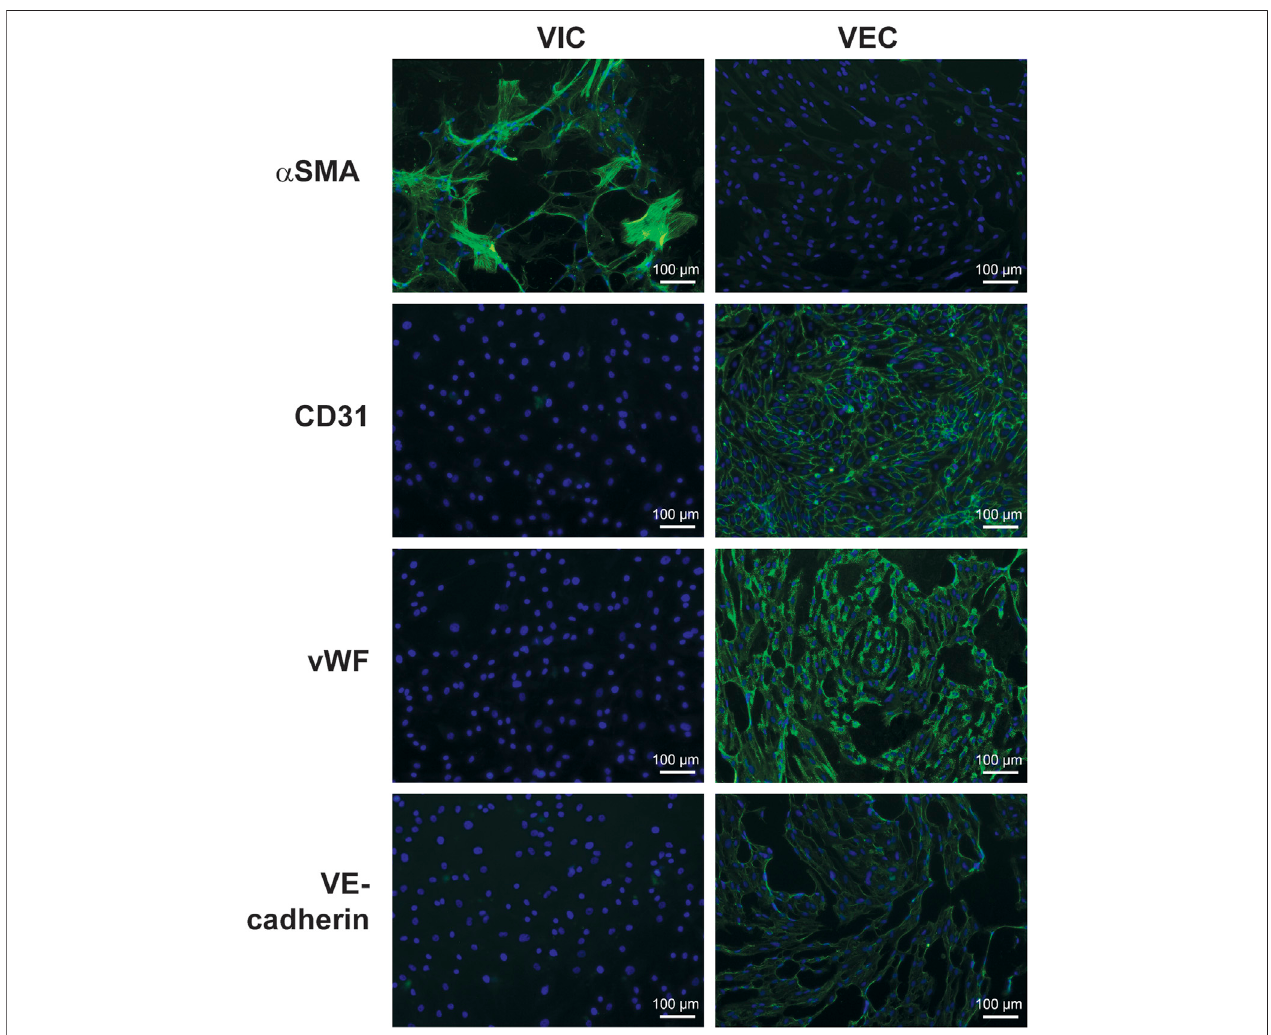
FIGURE 3 | Immuno fl uorescence staining for fi broblastic and endothelial markers in valve interstitial (VIC) and endothelial cells (VEC). Cells were isolated from humanaorticvalveswithcalci fi cation(n=3)andseparatedbymagnetic-activatedcellsorting.Thepicturesshowexpressionofalpha-smoothmuscleactin( α SMA)inVIC and clusterofdifferentiation31(CD31),vascularendothelialcadherin (VE-Cadherin),andvonWillebrandfactor(vWF)inVEC.ThenucleiwerestainedwithHoechst3342 (blue).